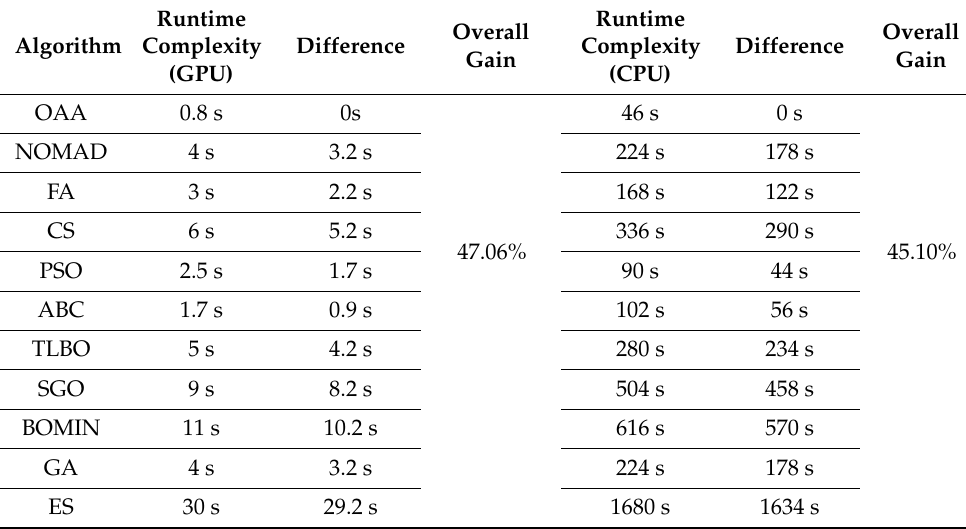
Table 6. Comparison of the runtime complexity of the proposed algorithm with